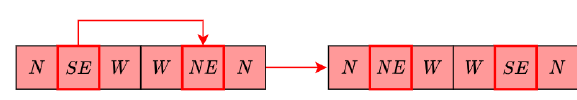
Figure 7. Two point crossing operation of two individuals.